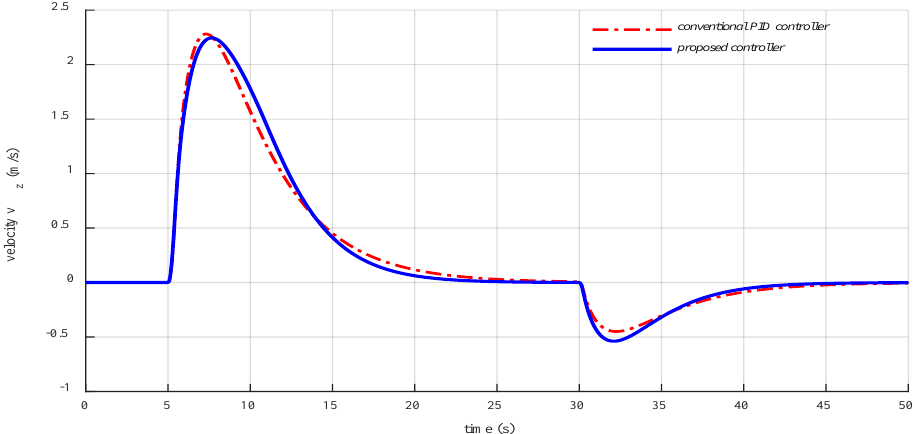
Figure 9. Comparison of the vertical velocity performance between our new controller and a conventional PID controller for Scenario 1.